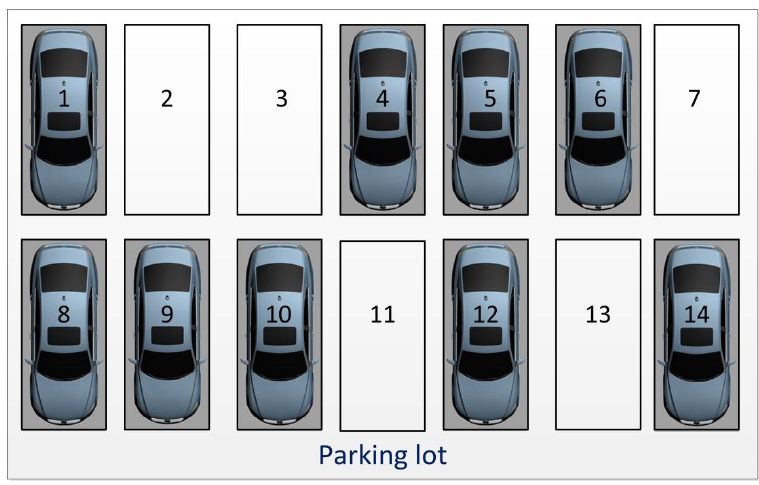
Figure 7. Parking space number.